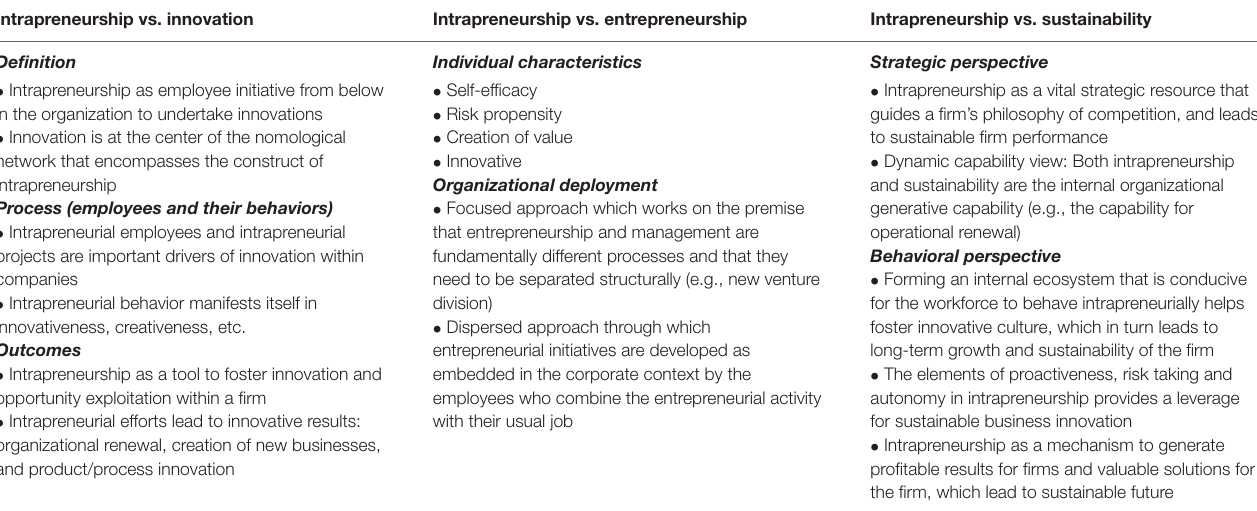
TABLE 1 | Relationships between intrapreneurship and innovation, entrepreneurship, and